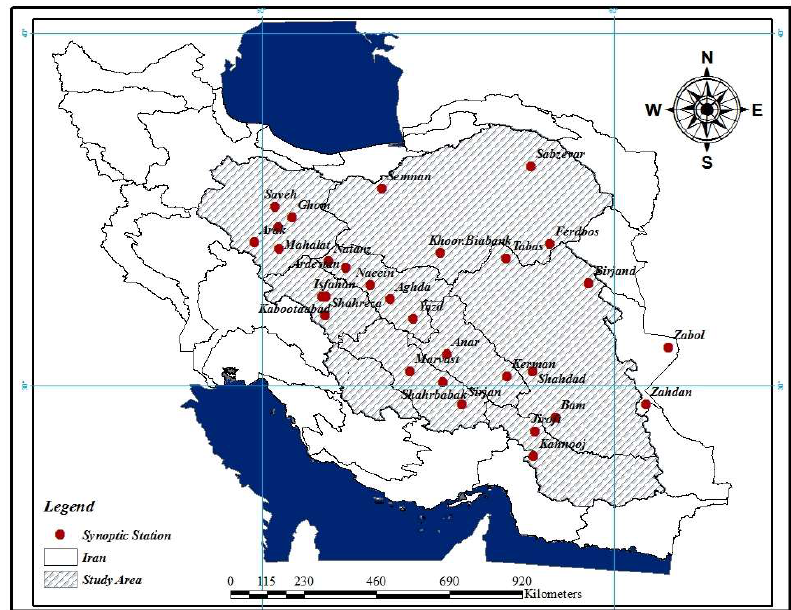
Figure 1. Geographical location of the study area.